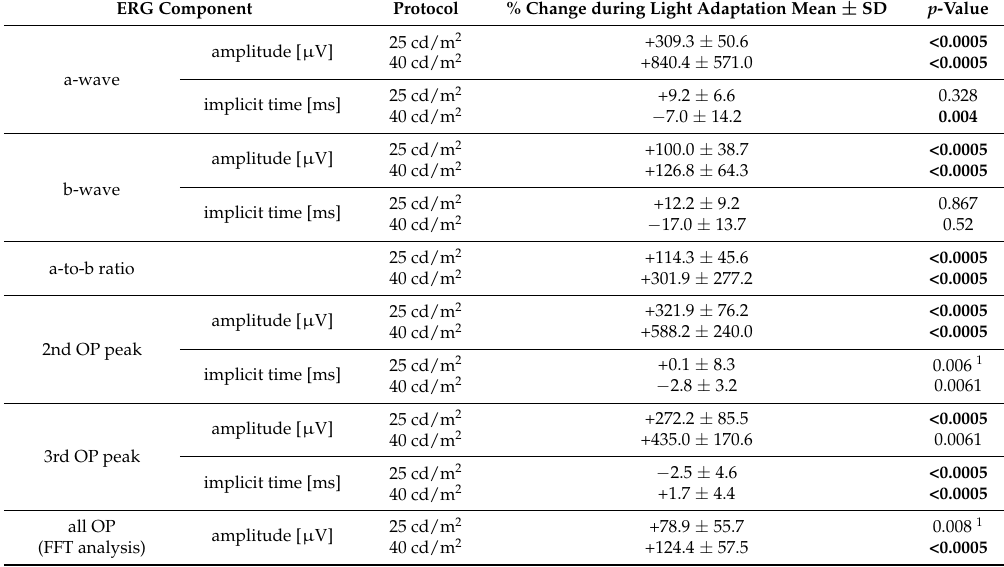
Table 2. Summary of statistical evaluation of the changes of ERG components during dark adaptation. A Friedmann-test was performed to analyze the increase/decrease of the parameters during dark adaptation. Significance level was corrected via the Bonferroni method: α Bonferroni = 0.005. p -Values that were significant after the Bonferroni correction are